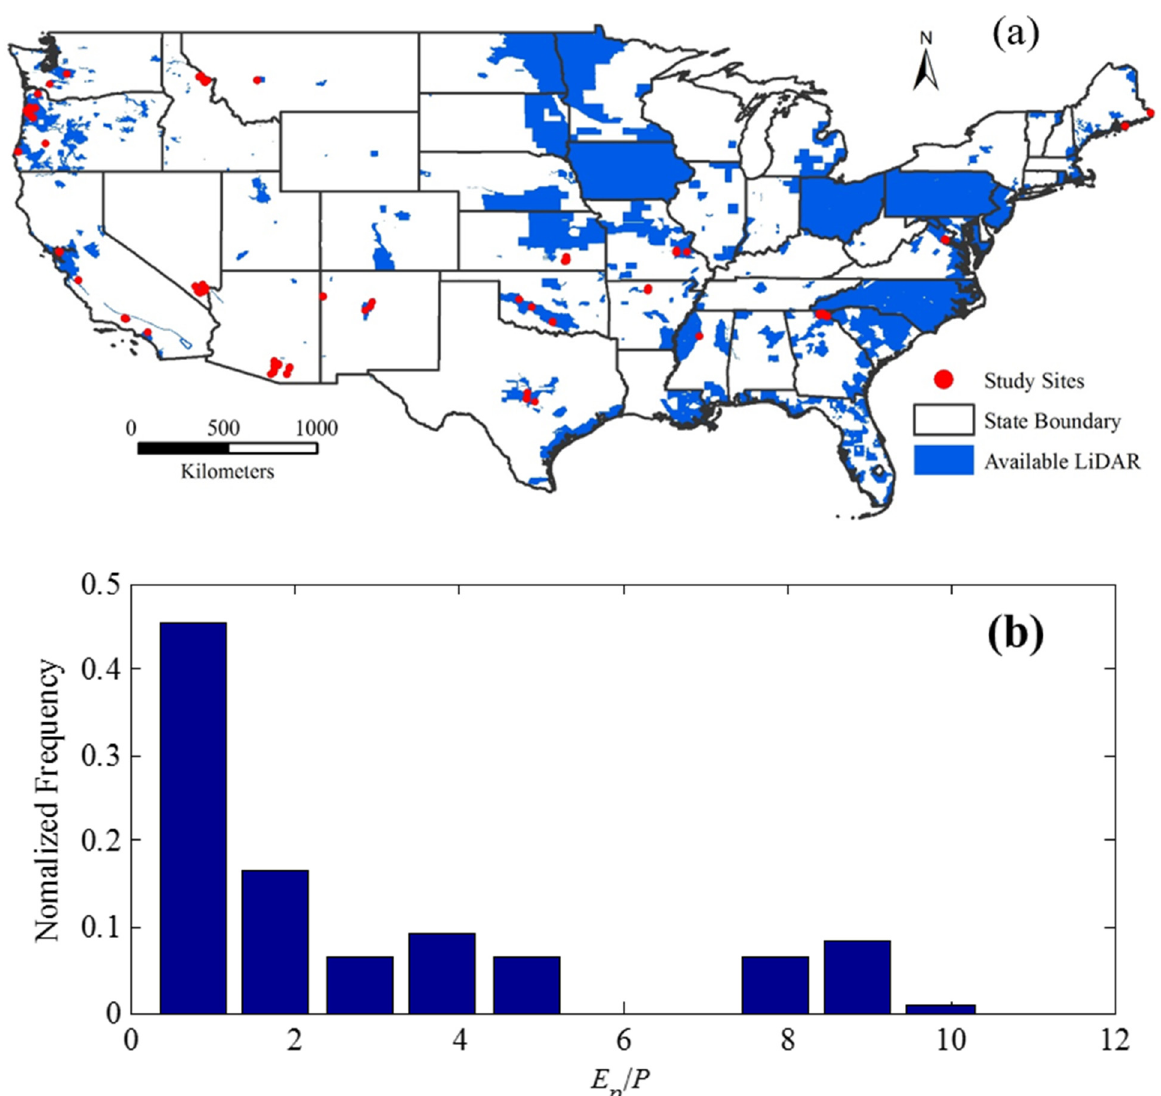
Figure 1. Study sites ( a ) Location of study sites and LiDAR data availability as of 2015 and ( b ) nor- malized frequency distribution of 𝐸 (cid:2926) /𝑃 for the study sites.